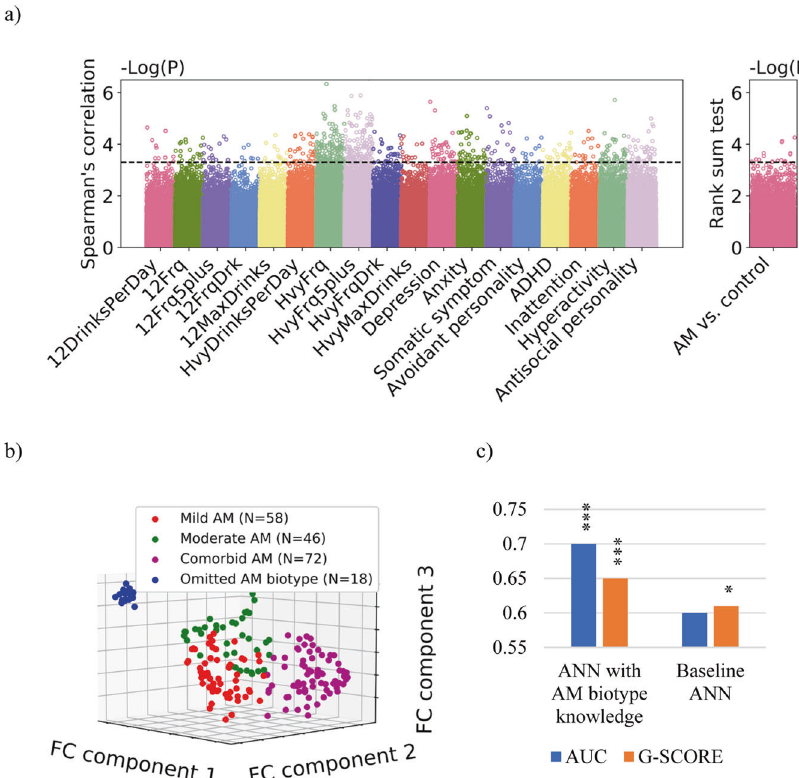
Fig. 2 Feature selection, cluster analysis and classi fi cation of AM subjects. a Manhattan plot showing how signi fi cantly each FC feature (a point in each column) is correlated with the alcohol use and clinical metrics (columns on the left; please refer to the section of alcohol use metrics in Table 1 for the full feature names) and differentiates AM from control (column on the right); the higher it is positioned on the plot, the more signi fi cant it is. The FC features showing a correlation at P < 0.005 (i.e., above the horizontal line) were included in UMAP. b K-means clustering results on the basis of the three dimensions revealed by UMAP. c Classi fi cation performance of the ANN classi fi er with AM biotype knowledge as compared with baseline ANN (i.e., without biotype knowledge). The implementation of these ANNs is described in Supplementary Methods. G-score = the square root of the product of the sensitivity and speci fi city of a classi fi er. * P < 0.05, ** P < 0.01, *** P < 0.005 in permutation